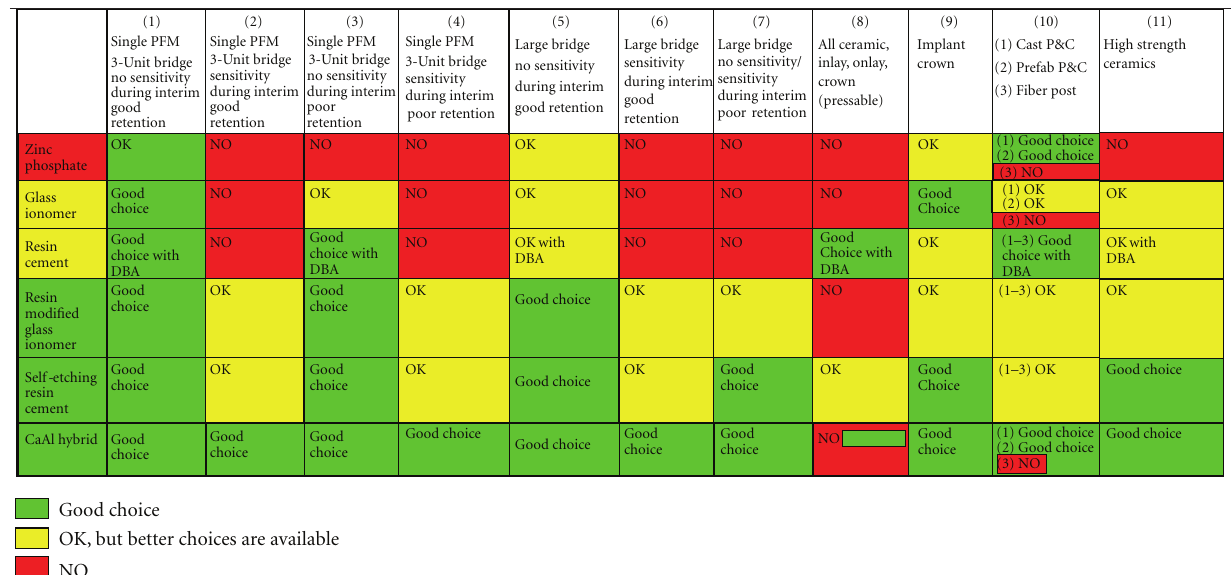
Table 3: Clinical indications for use of luting